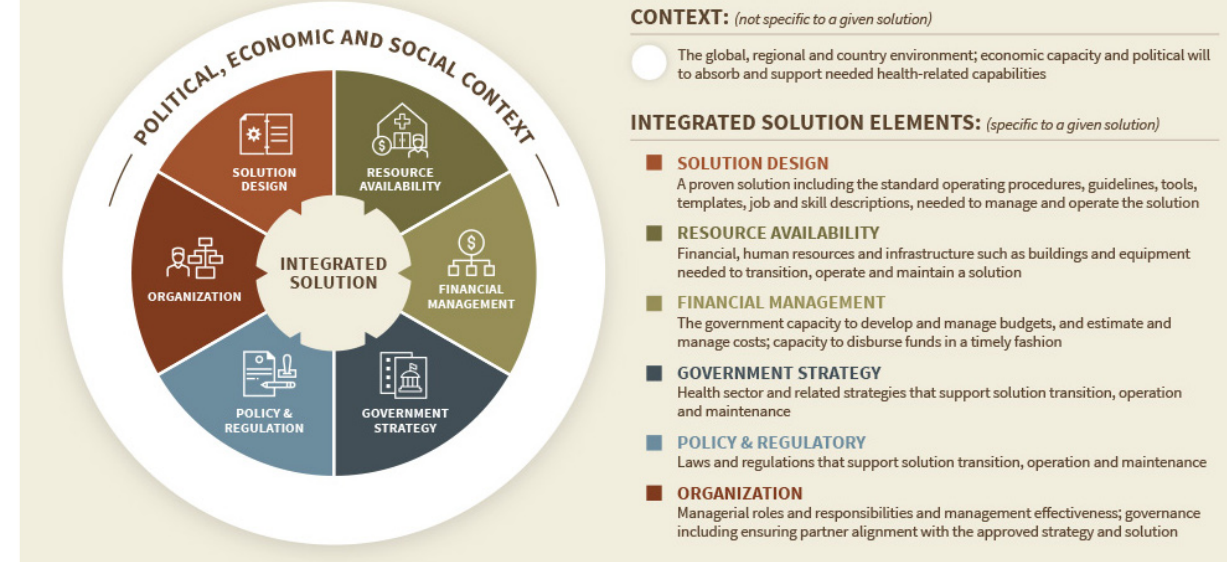
Figure 1. Transition to government theoretical